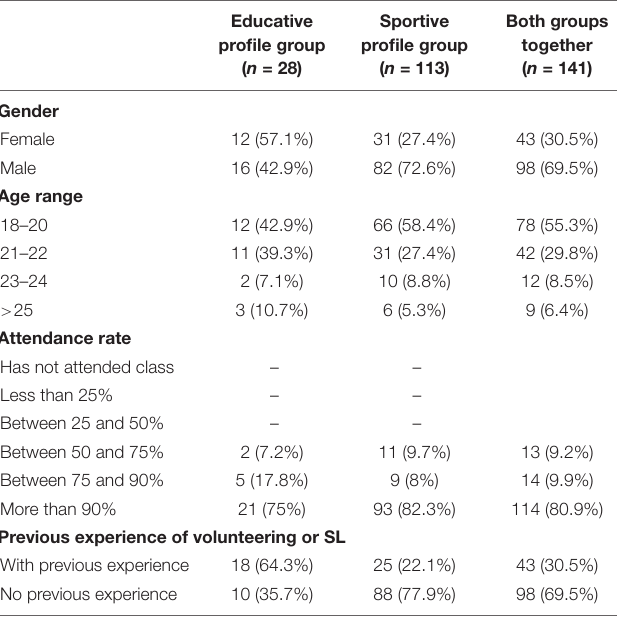
TABLE 1 | Sociodemographic characteristics of the